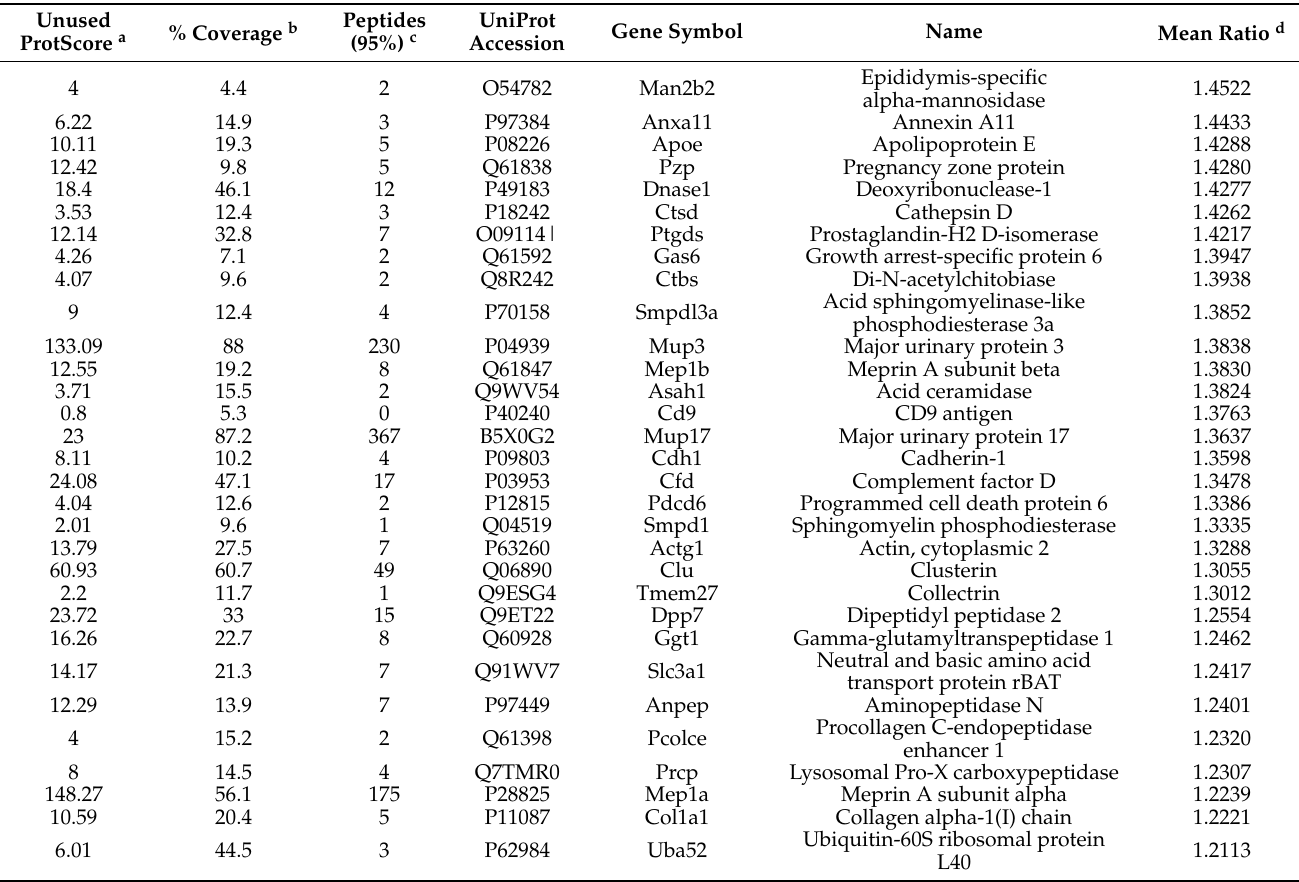
Table 1 shows the different proteins between J20 and WT meeting the following criteria: (1) FDR < 5%. (2) The number of distinct peptides with at least 95% confidence ≥ 1. (3) The protein can be detected with ratio at least two times in three biological replicates. (4) Fold change of 1.2. a : Unused ProtScore is a score of protein confidence, and reflects the amount of total and unique peptide evidence related to an identified protein. Unused ProtScore is calculated from the peptide confidence that has not yet been ‘used’ by higher scoring proteins in the experiments. b : The percentage of matching amino acids from the identified peptides. c : The number of distinct peptides with at least 95% confidence in the experiments. d : The ratio represents 115/114 ratio. 115 and 114 were used to label exosomal proteins from J20 mice and wild type mice, respectively. iTRAQ: isobaric tag for relative and absolute quantitation. U-exo: urine exosomes. Table 2. The different proteins we identified in N-exo between WT and J20